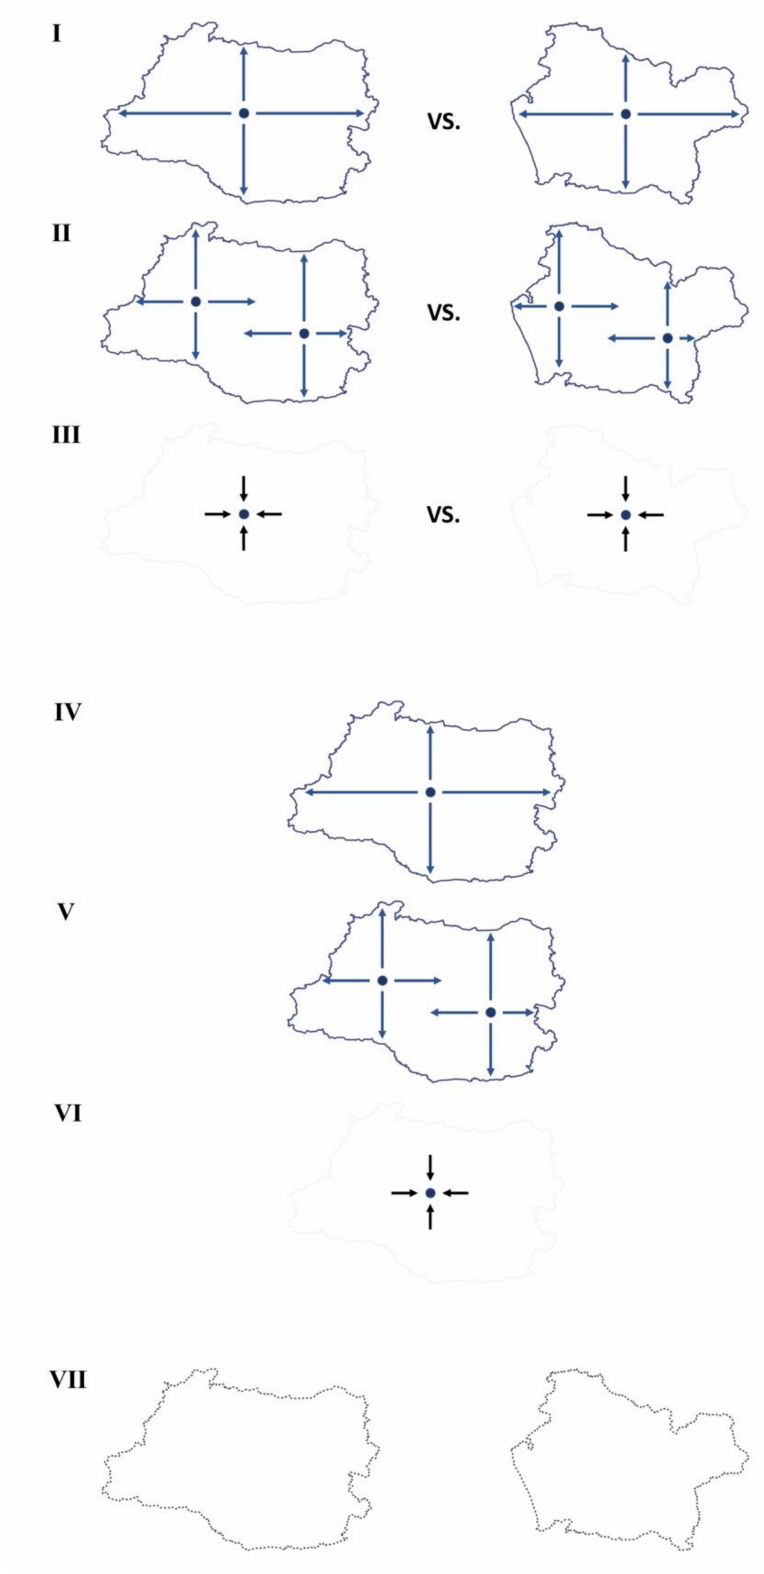
Figure 5. Seven main types of climate-oriented researches in